Question: What does this figure show? Answer in one sentence.
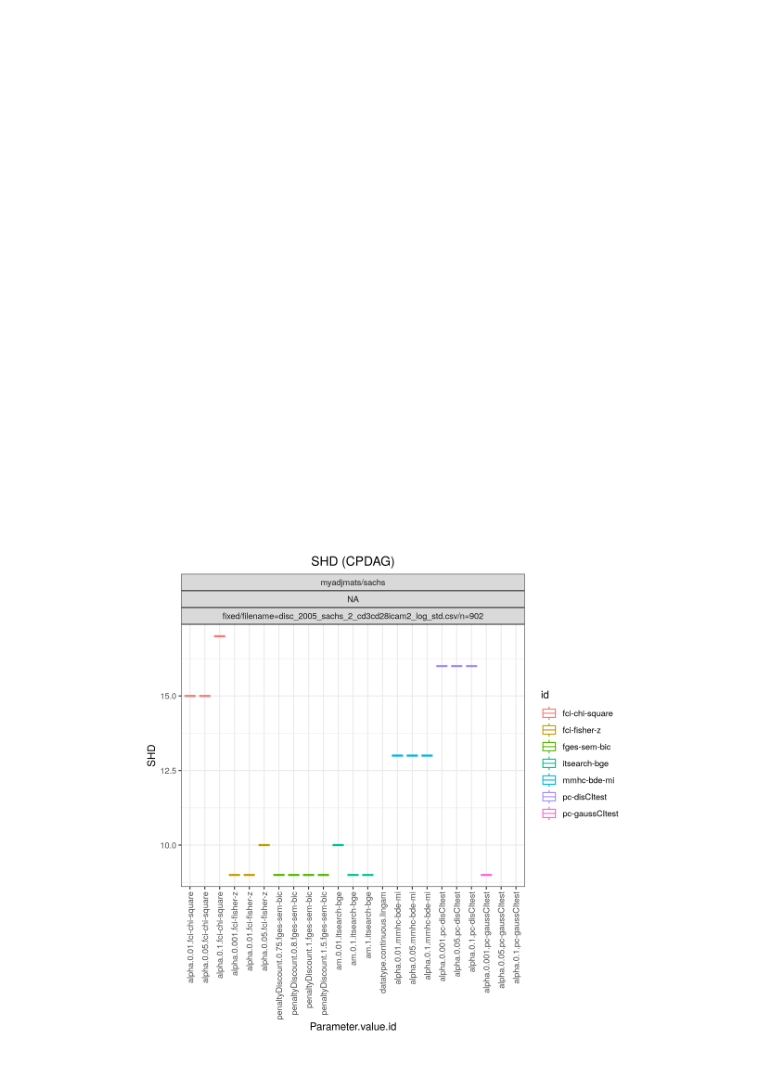
Answer: SHD Scores on the Sachs data set. Discretized, no noise.